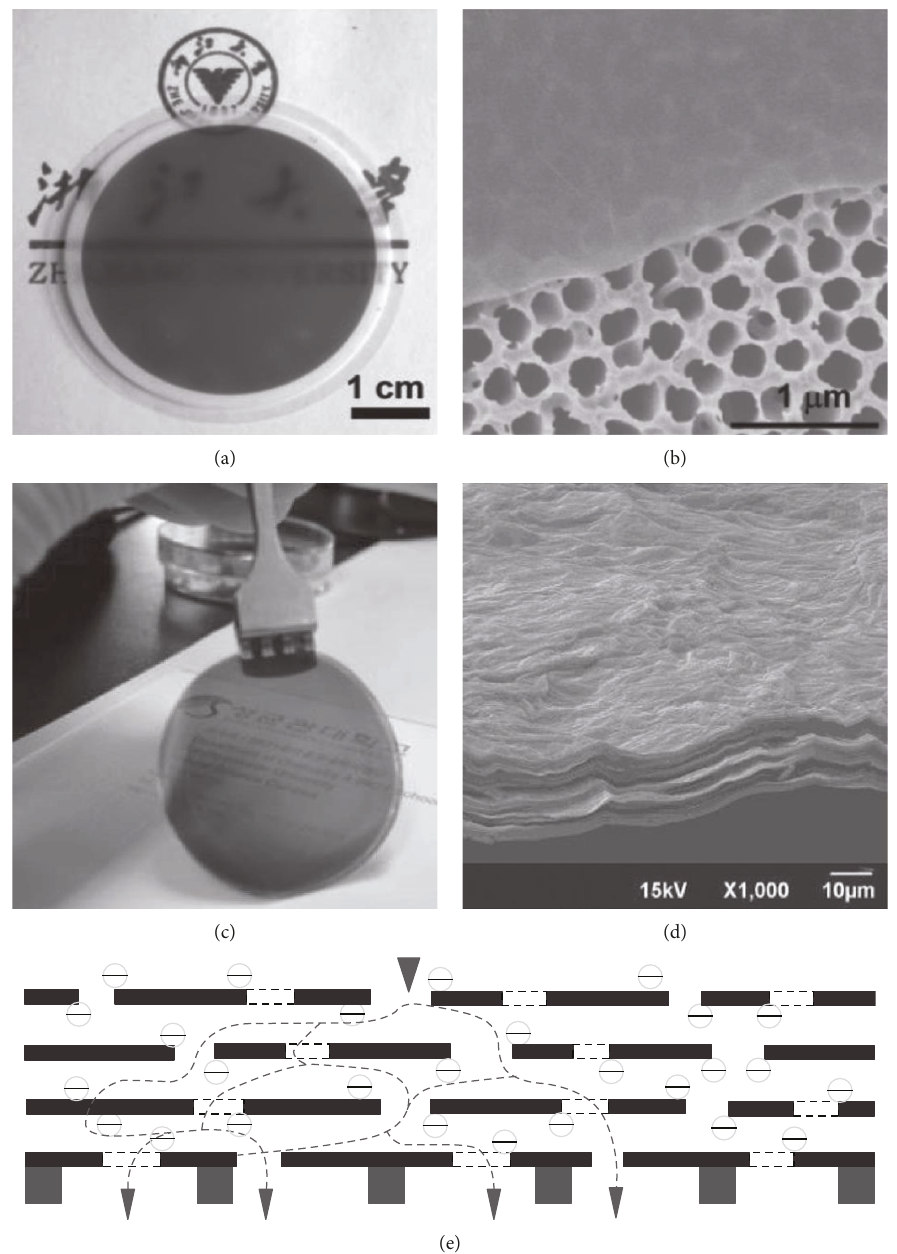
Figure 3: Digital photo of an rGO membrane coated on an AAO disk (a); SEM image (top view) of the coating of an rGO membrane on an AAO disk. The top half of the image shows the uniform and smooth coating of rGO sheets, whereas the bottom half shows the porous structure of the bare AAO disk. Reprinted with permission from [64]. Digital photo (c) and SEM (cross-sectional view) image (d) of self- standing GO membrane. Reprinted with permission from [65]. In (e), a schematic view for possible permeation route is shown: water molecules go through the nanochannels of the rGO membrane and the holes on the graphene sheets and at last reach the pores of supporting membranes. The blank squares present the holes on the graphene sheets (black line). The edges of the rGO and the periphery of the holes are negatively charged. Reprinted with permission from